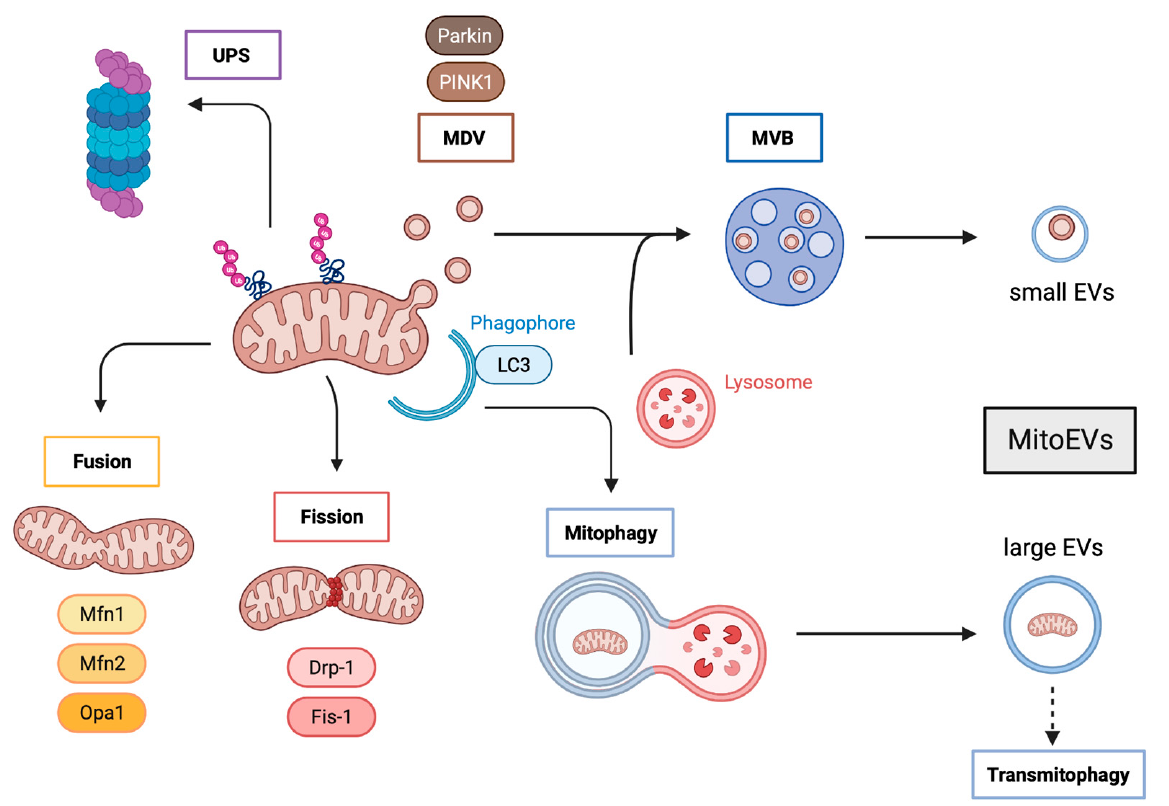
Figure 1. Mitochondria quality control and MitoEVs formation. Aberrant mitochondrial components can be degraded by the UPS, but also be incorporated in MDV that fuse with lysosomes to form MVB, leading to the formation and delivery of small mitoEVs. Whole damaged mitochondria are subjected to fusion and fission processes, the latter ending in mitophagy and promoting transmi- tophagy through the formation and release of large mitoEVs. UPS: Ubiquitin proteasome system; MDV: mitochondria-derived vesicles; MVBs: multivesicular bodies; PINK1: PTEN-induced puta- tive protein kinase 1; MVB: multivesicular bodies; EVs: extracellular vesicles; Mfn1: mitofusin 1; Mfn2: mitofusin 2; Opa1: optic atrophy 1; Drp-1: dynamin-related protein 1; FIS1: mitochondrial fission protein 1; LC3: microtubule-associated protein 1 light chain